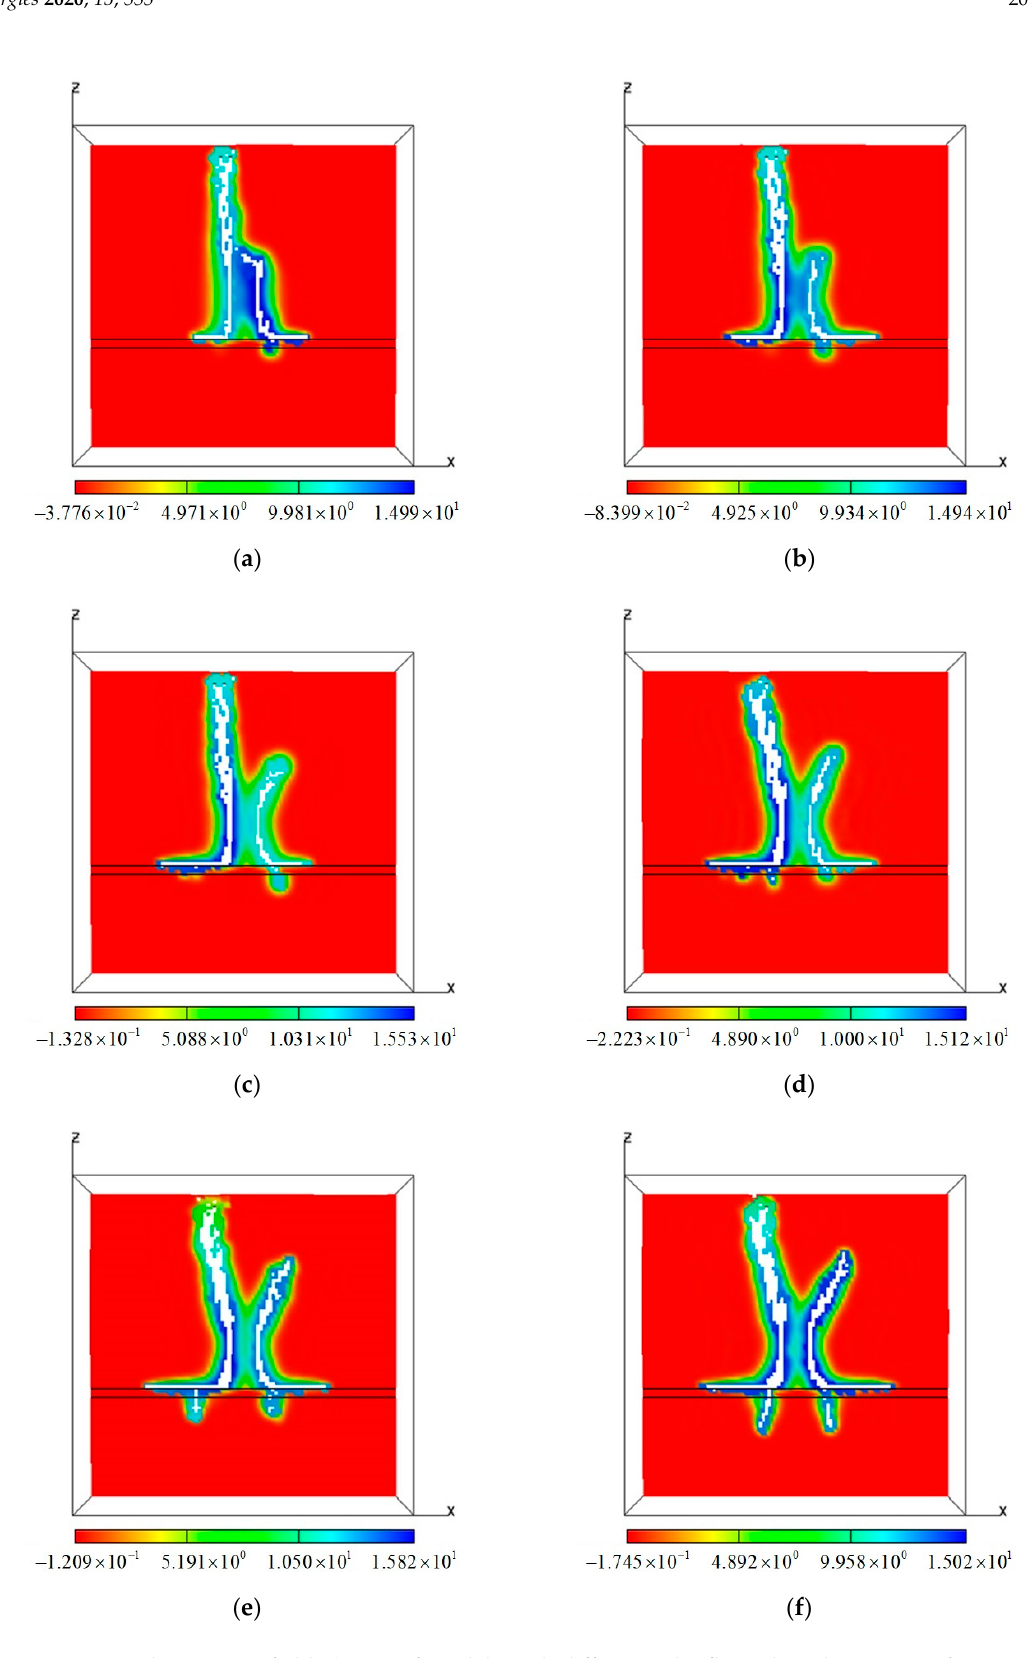
Figure 16. The seepage fields (MPa) of models with different inlet flux when the primary fracture reaches the boundary: ( a ) Multi-Q1, t = 3120 s, Q 1 / Q 0 = 0.5; ( b ) Multi-Q2, t = 2480 s, Q 2 / Q 0 = 0.7; ( c ) Multi-01, t = 2120 s, Q o / Q 0 = 1.0; ( d ) Multi-Q3, t = 1920 s, Q 3 / Q 0 = 1.25; ( e ) Multi-Q4, t = 1640 s, Q 4 / Q 0 = 1.75; ( f ) Multi-Q5, t = 1560 s, Q 5 / Q 0 = 2.0. The upper radius and lower radius of the primary and secondary fractures in models with different flux ratios are shown in Figure 17. The upper radius curve of the primary fracture is a horizontal line because of the choice of the special statistical moment. The upper radius of the secondary fracture increases with the increase of the inlet flux, which is consistent with the seepage field diagrams. Because the larger the inlet flux is, the faster the fluid pressure in the secondary fracture increases after the initiation of the primary fracture, the easier it is to crack. The upper radius of the secondary fracture at the ratio of 0.5 deviates from the curve, mainly because of the upper part of the secondary fracture merging into the primary fracture. The lower radius of the secondary fracture rises except for the segment between the ratio of 1.0 and 1.25. By comparing the upper radius curve and the lower one of the secondary fracture, it is found that there is a point of intersection when the ratio of flux equals 1.1. Before this point, the flux is small and the secondary fracture barely crosses the barrier, so the upper radius of the secondary fracture is larger than the lower one. After the intersection point, partial fluid penetrates the barrier, so the lower radius increases beyond the upper radius.